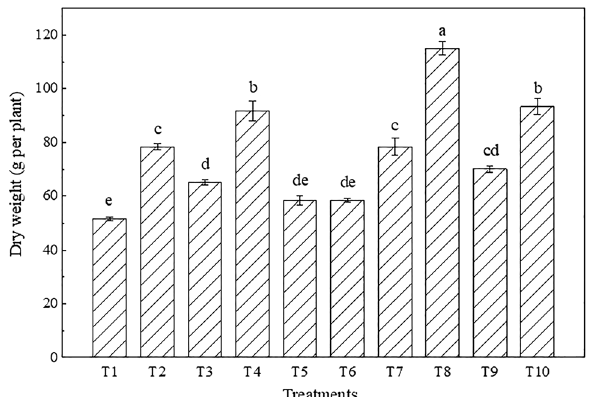
Figure 10. Dry weight under the different treatments (the different letters denote significant differences at the 0.05 level).